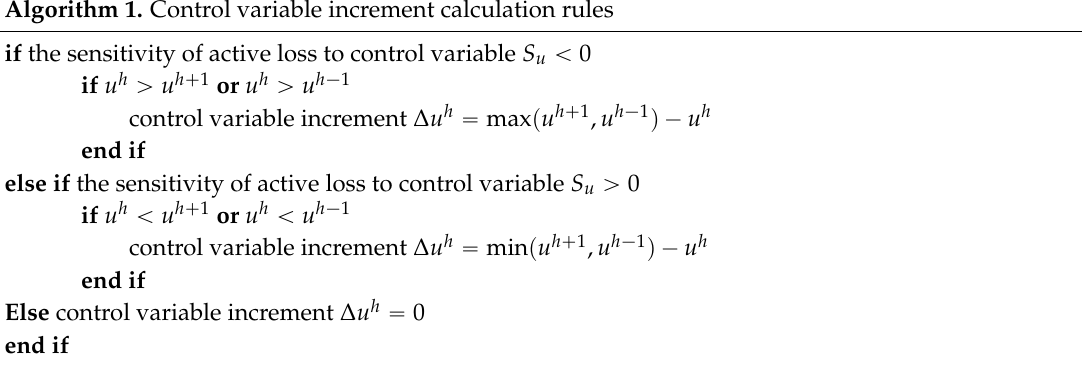
Algorithm 1. Control variable increment calculation